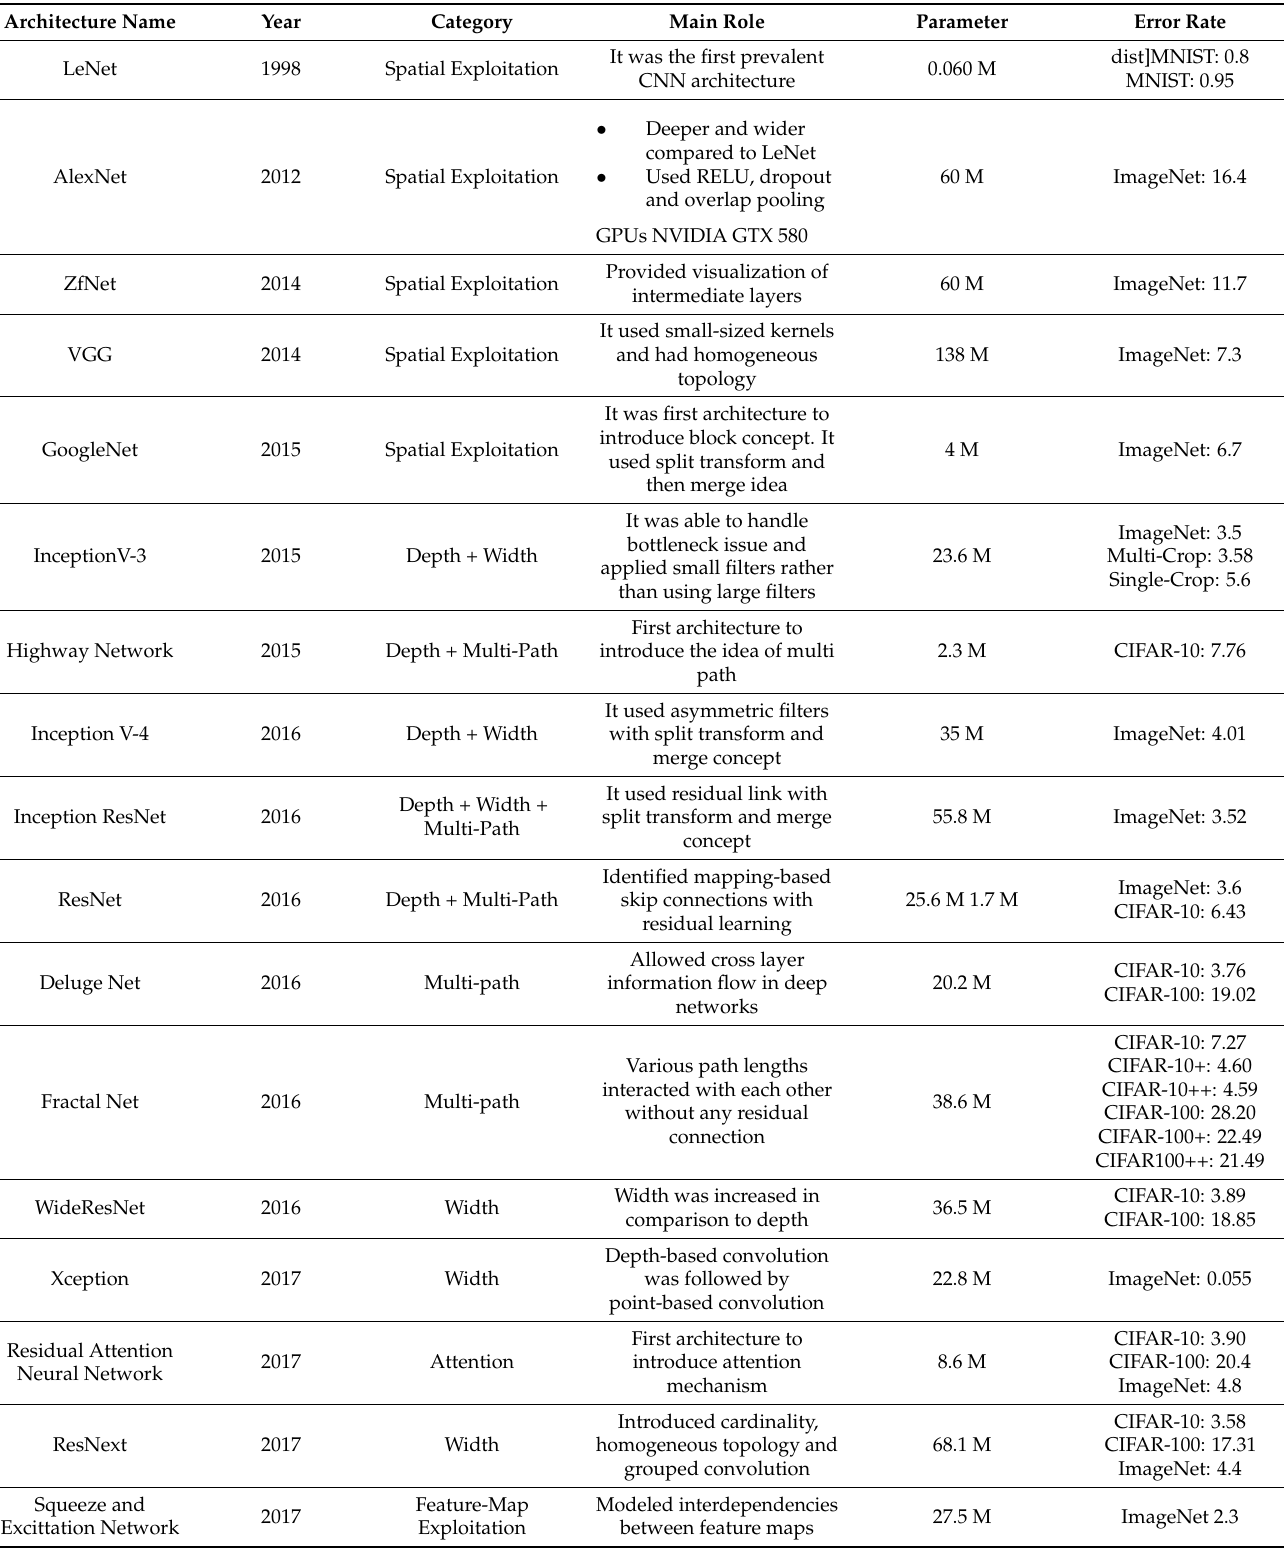
Table 1. Performance summary of various CNN variants with its architectural